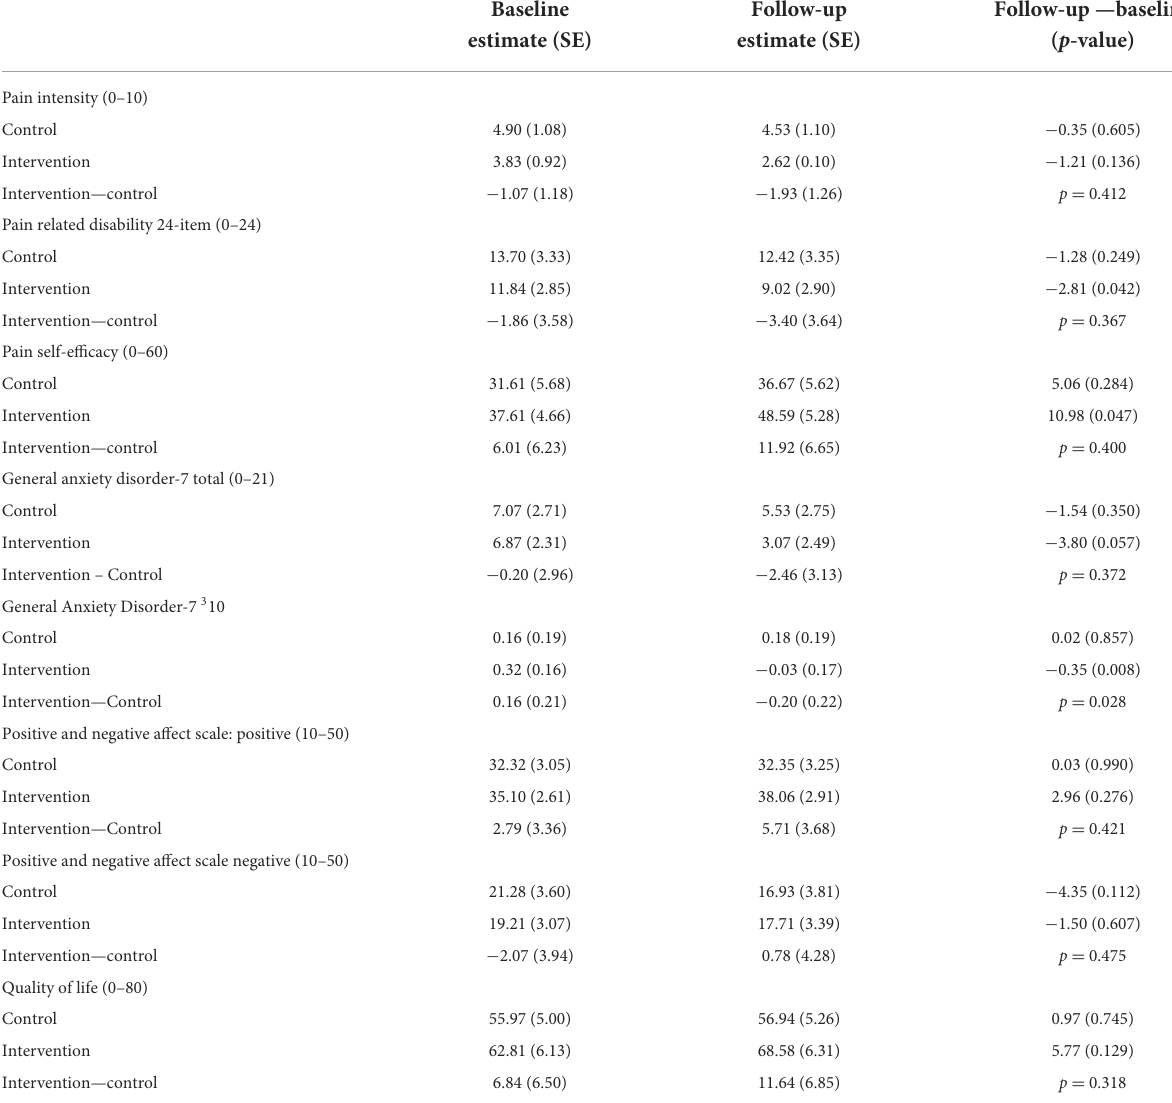
TABLE 2 Examination of the effects of the intervention.